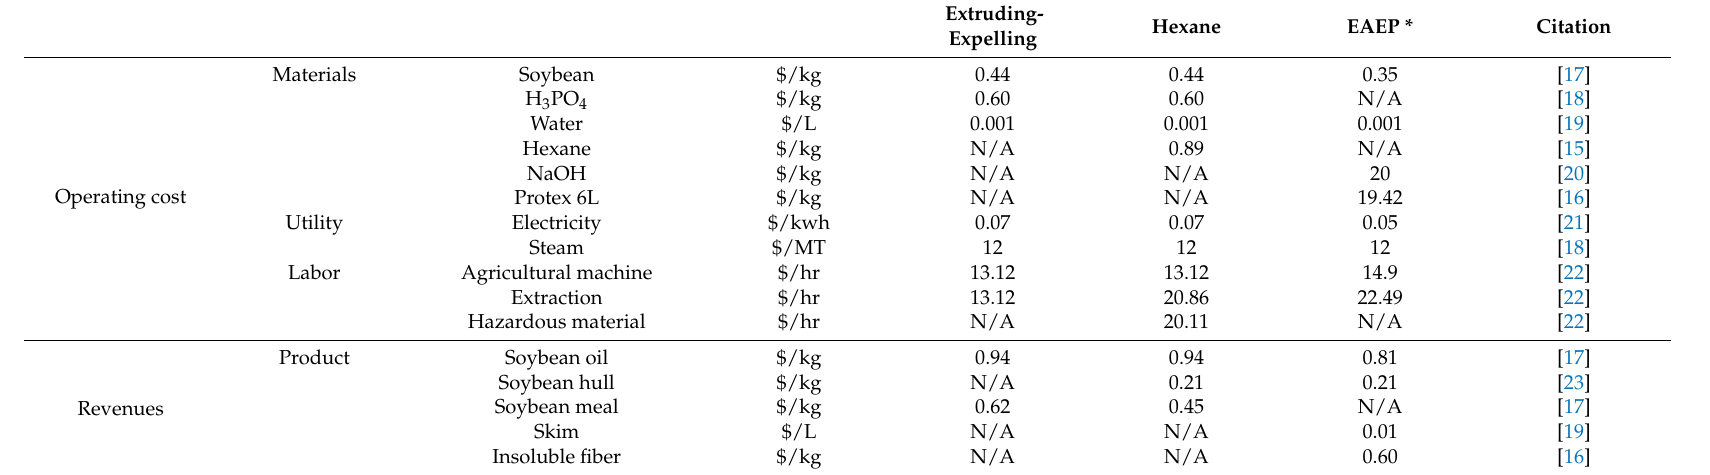
Table 1. Operating costs and products selling price inputs (2015 price value).